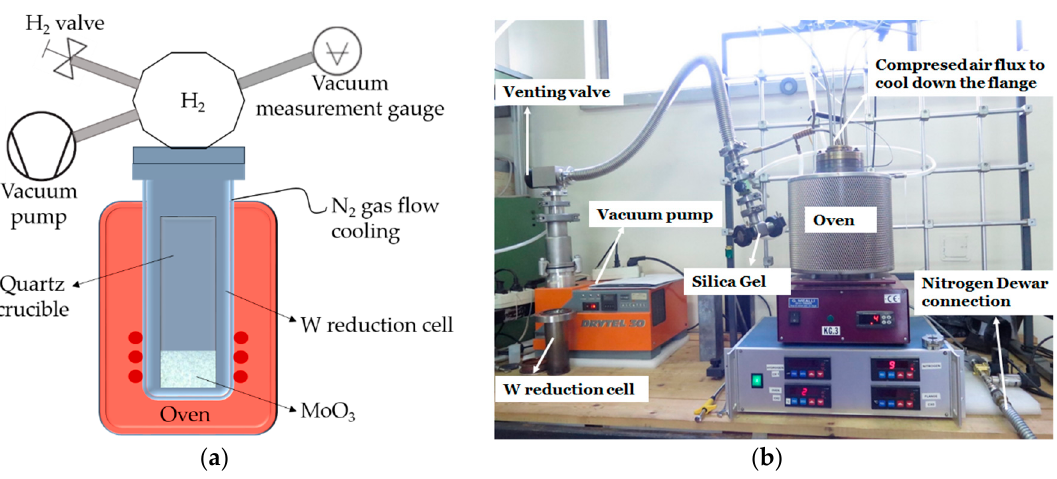
Figure 4 Reduction system scheme ( a ) and the laboratory prototype ( b ). Figure 4. Reduction system scheme ( a ) and the laboratory prototype ( b